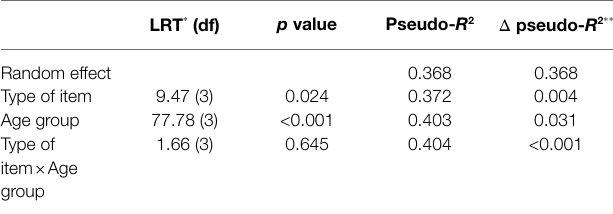
TABLE 2 | Results of the generalized mixed model on accuracy in Experiment